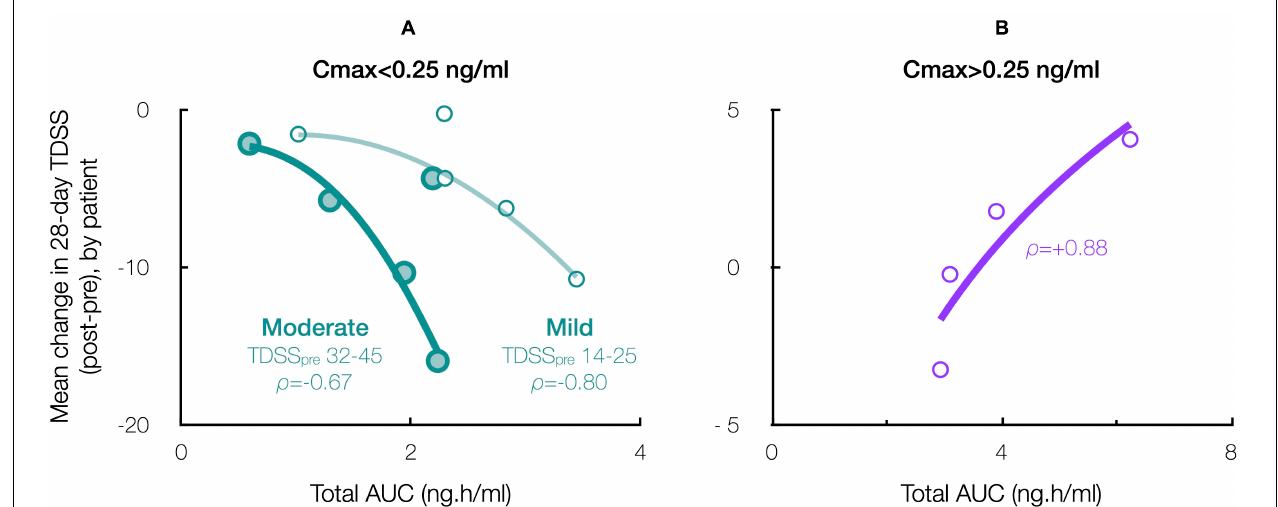
FIGURE 7 | Effect of CT38 total AUC on the patient-specific change in 28-day mean TDSS, with ρ = Pearson’s correlation coefficient, for CT38: (A) Cmax < 0.25 ng/ml (green), stratified by TDSS pre (moderate: large circles, dark line; mild: small circles, light line); or (B) Cmax > 0.25 ng/ml